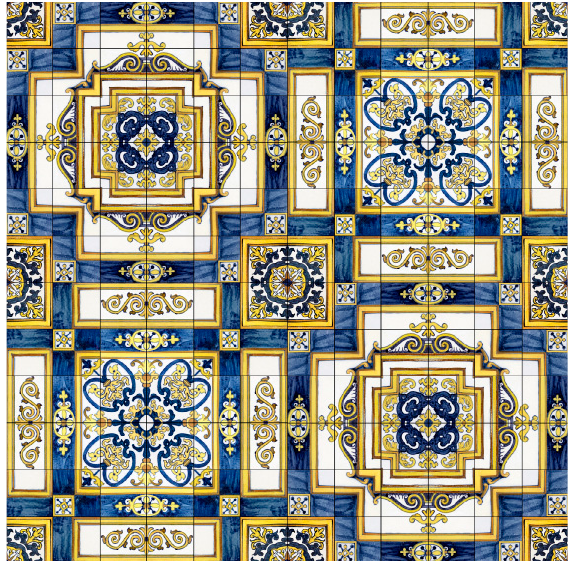
FIGURE 10 | The ‘Marvila’ pattern P-17-00999, found on Church of Marvila, in